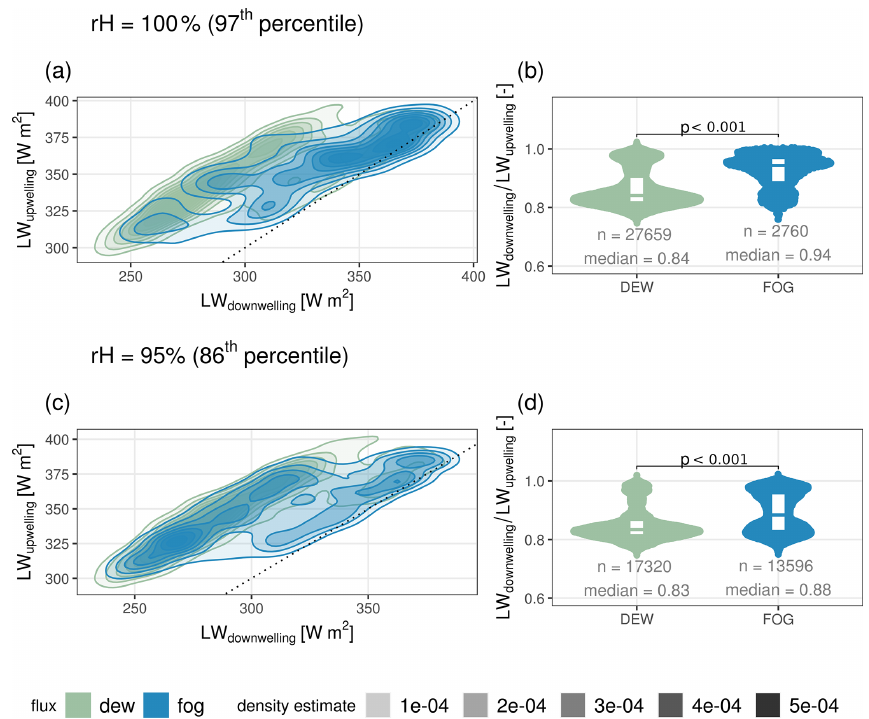
Figure G3. Comparison of upwelling LW and downwelling LW during the conditions classified as having fog and dew from the flux partitioning of the lysimeter weight changes based on a rH threshold of 100% (a, b) and 95% (c, d) . Panels (a) and (c) illustrate the smoothed kernel density estimate, with the black dotted line displaying the identity line. Panels (b) and (d) illustrate the distribution of radiation ratios during dew and fog conditions. The differences between the distributions are statistically significant, with a significance level p < 0 .